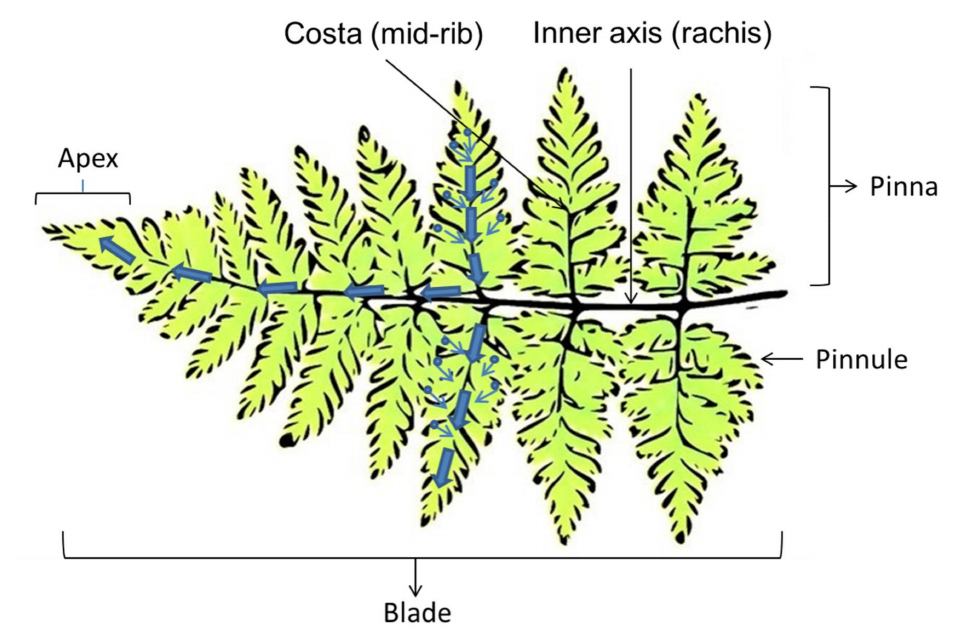
Figure 9. Schematic showing various parts of the fern leaf and the presumed directions of the water transport, which is based on the orientation of the leaf and gravity.